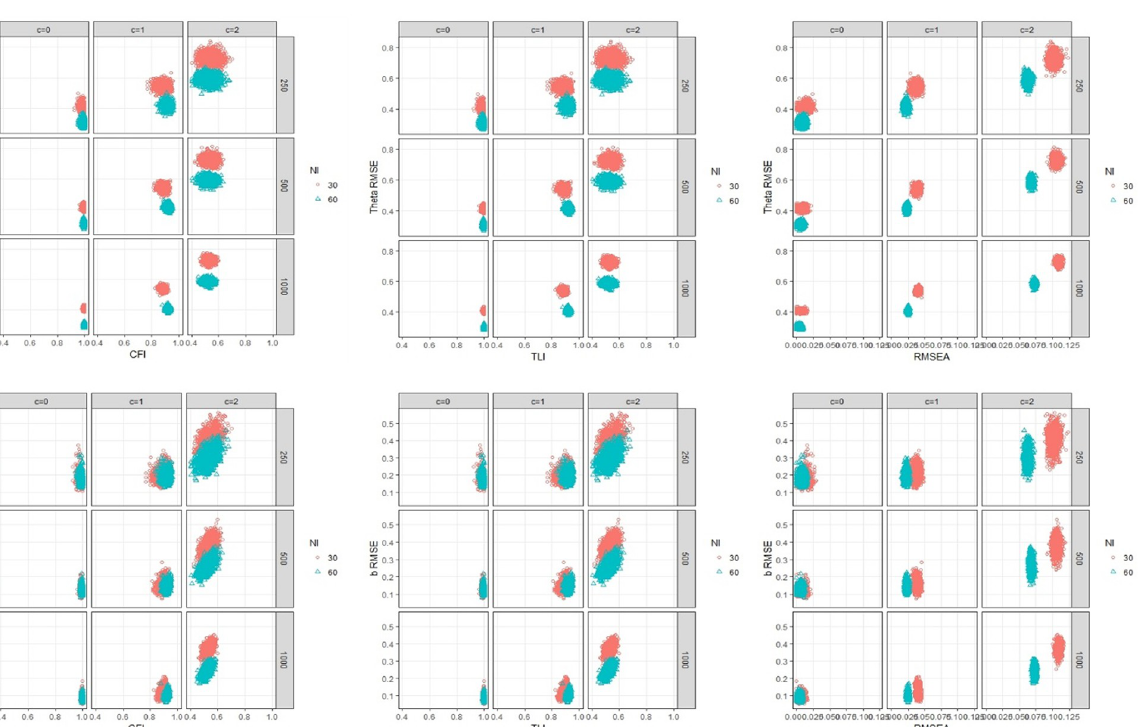
PLOS ONE | https://doi.org/10.1371/journal.pone.0271992 September 15,